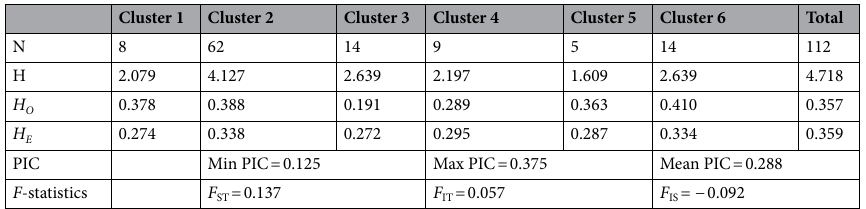
Table 1. Genetic diversity among 112 Luffa acutangula accessions based on STRU CTU RE analysis. N number of accessions, H Shannon & Weiner diversity index, H O observed heterozygosity, H E expected heterozygosity, PIC polymorphism information content, F ST differentiation among populations, F IT total fixation index, F IS fixation index within populations.